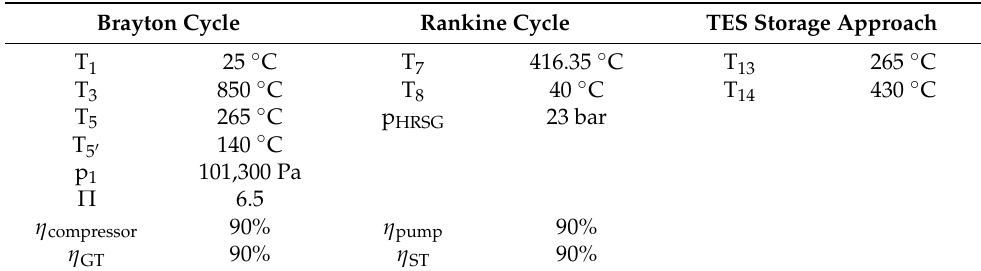
Table 1. Power plant layout boundary conditions.